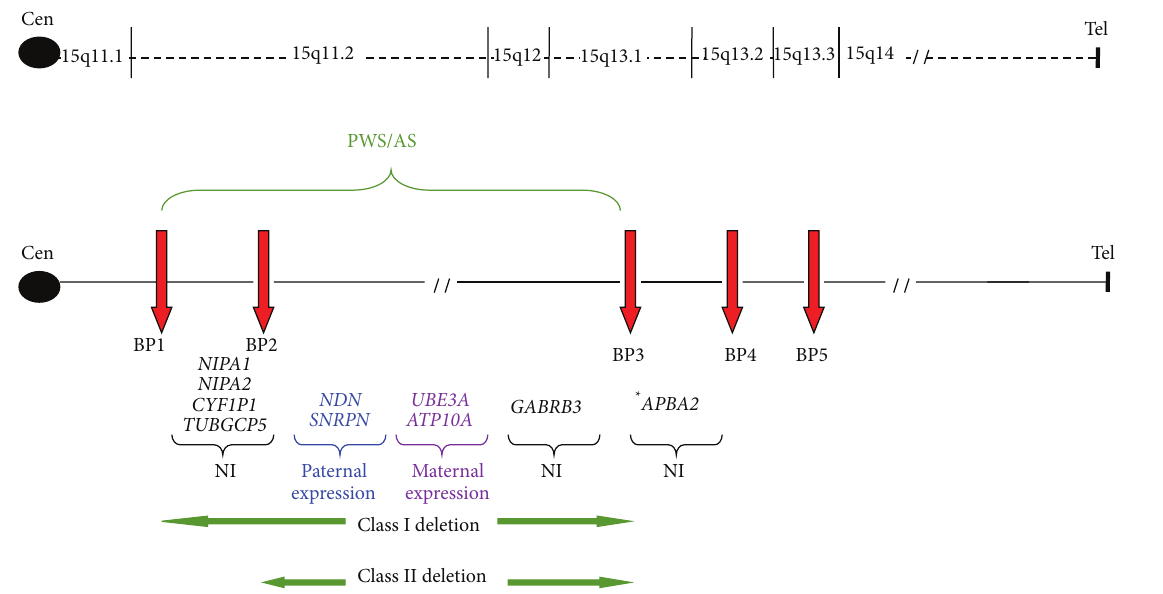
Figure 1: Chromosome 15 ideogram showing breakpoints BP1–BP5 in 15q11.2-q13 and the PWS/AS common deletion regions (green). Genes located in each breakpoint interval are shown below (blue = paternal expression/maternal imprint; purple = maternal expression/paternal imprint; black = biallelic expression/no imprint). * APBA2 is a nonimprinted gene utilized in MS-MLPA (see Figure 2).